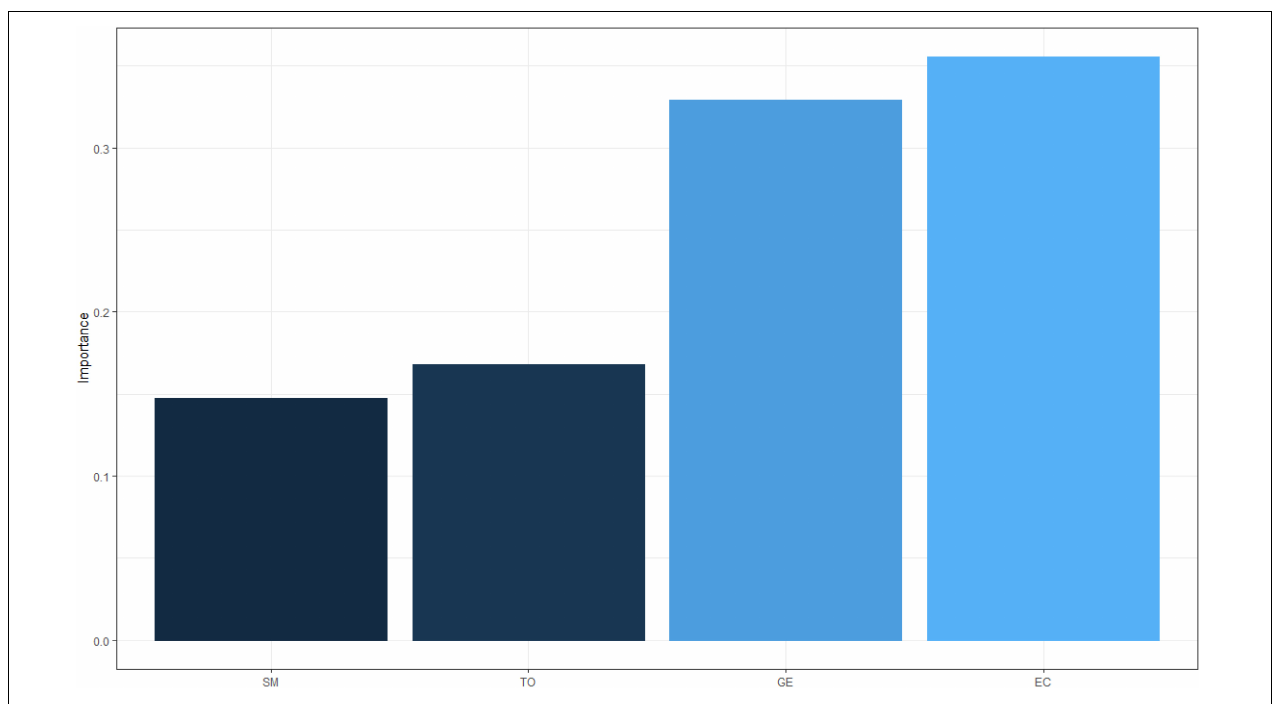
FIGURE 3 | Weight of independent